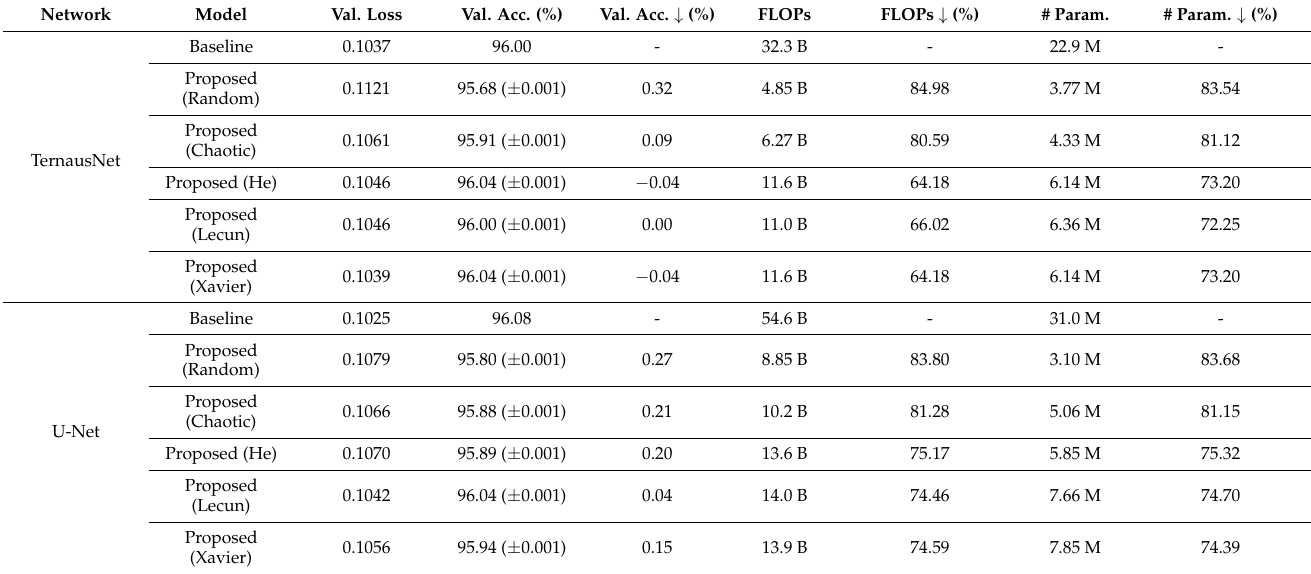
Table 1. Results of pruning TernausNet and U-Net on Inria dataset. “Baseline” represents the normal training results, i.e., without pruning. “ ↓ ” represents the reduction rate, which is the drop between the performance of the pruned model and the baseline model. A negative value in “Val. Acc. ↓ ” specifies an improvement in the model accuracy. B = billion, M =